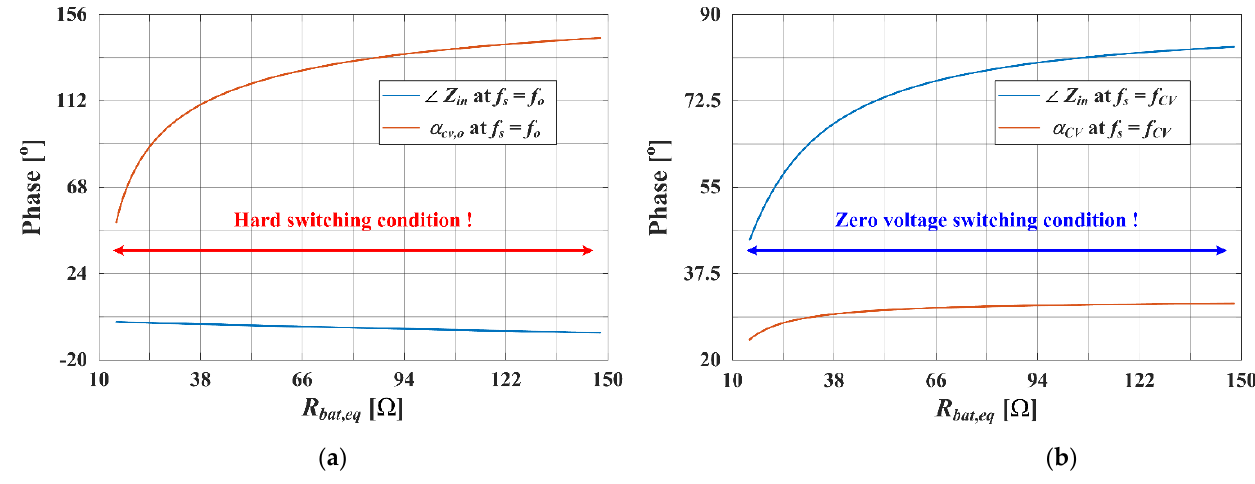
∠ Z in and α CV at f s = f CV